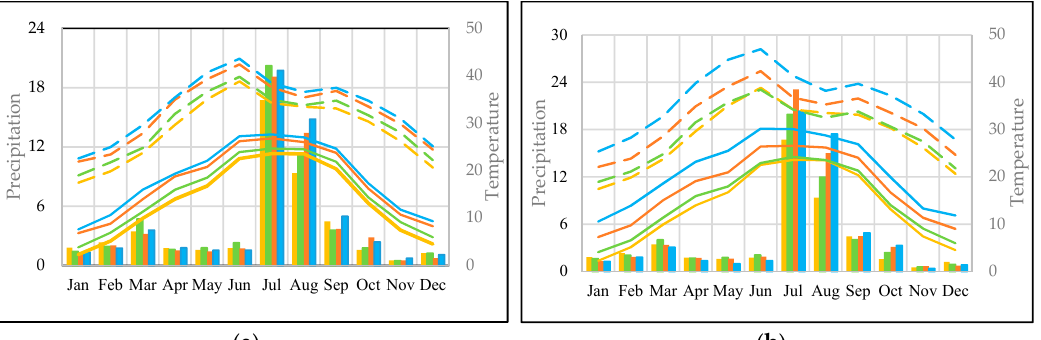
Figure 4. Mean monthly precipitation, maximum and minimum temperature for baseline and future period at P-2 under ( a ) RCP 4.5; ( b ) RCP 8.5. (Note: The bars represent the precipitation in mm/day, dashed lines represent maximum temperature in °C and the solid lines represent the minimum temperature in °C. Yellow color represents the baseline period, green color represents the early century, orange color represents the mid-century and the blue color represents the late century).